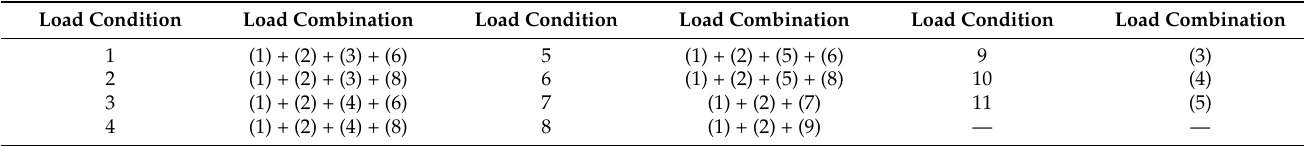
Table 8. Load conditions and load combinations.